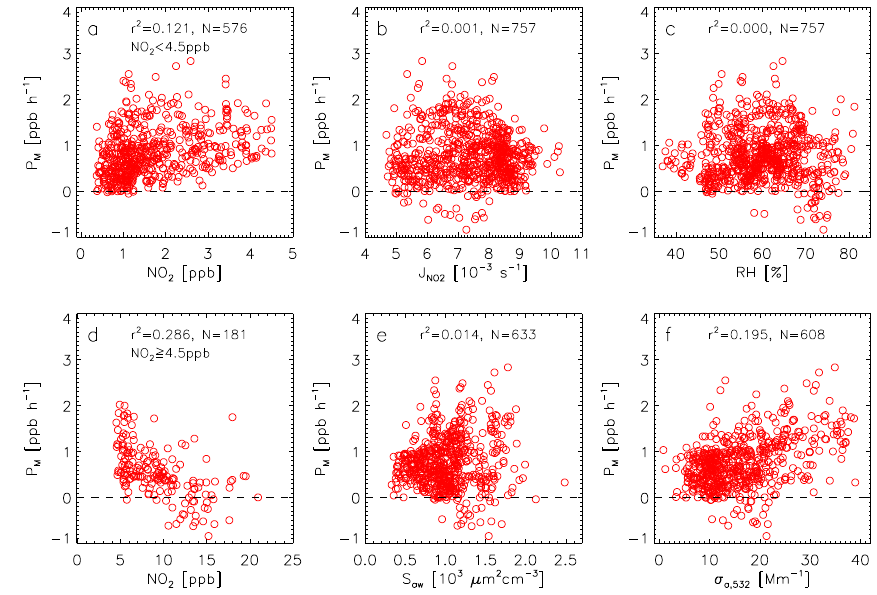
Fig. 9. Correlation of P M against NO 2 , J NO